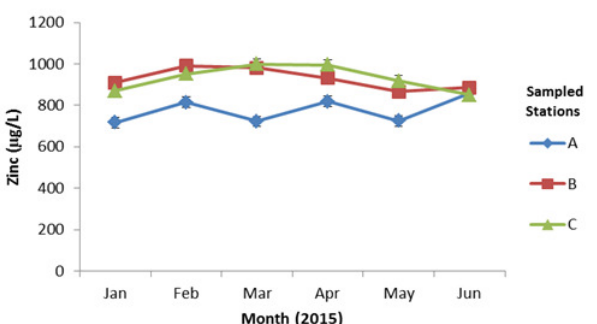
Fig. 15. The monthly mean variation in the Zinc (mg/L) levels sampled from Saba